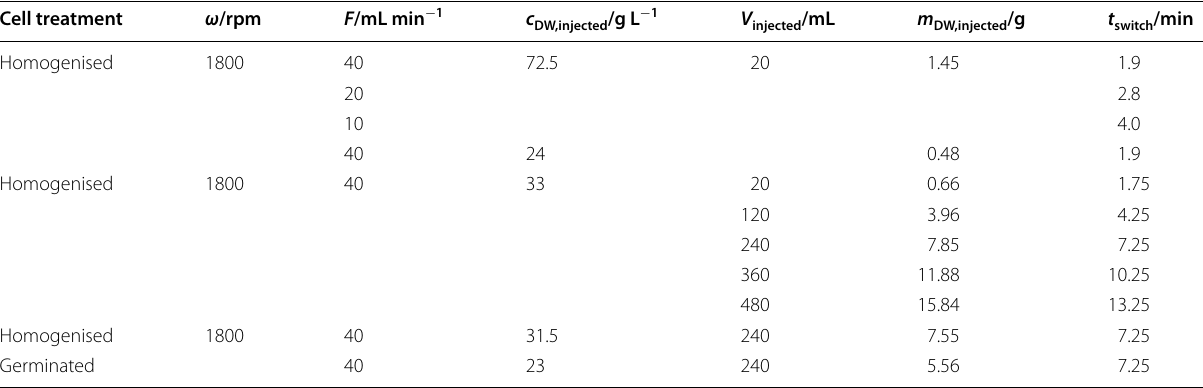
Table 1 Examined operating conditions of the used CPE column Cell